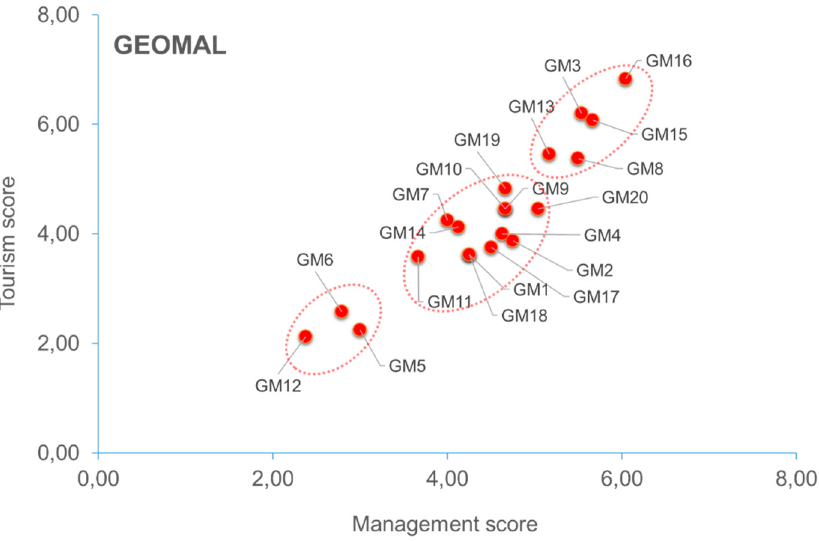
Figure 9. Clustering of the 20 geosites in the Malta study area. Table 2. General numerical assessment of the 20 sites of the Malta study area (GEOMAL). Legend: SV, scientific value; AV, additional value; UV, use value; MR, management rating; TR, tourism rating. Malta Geosites